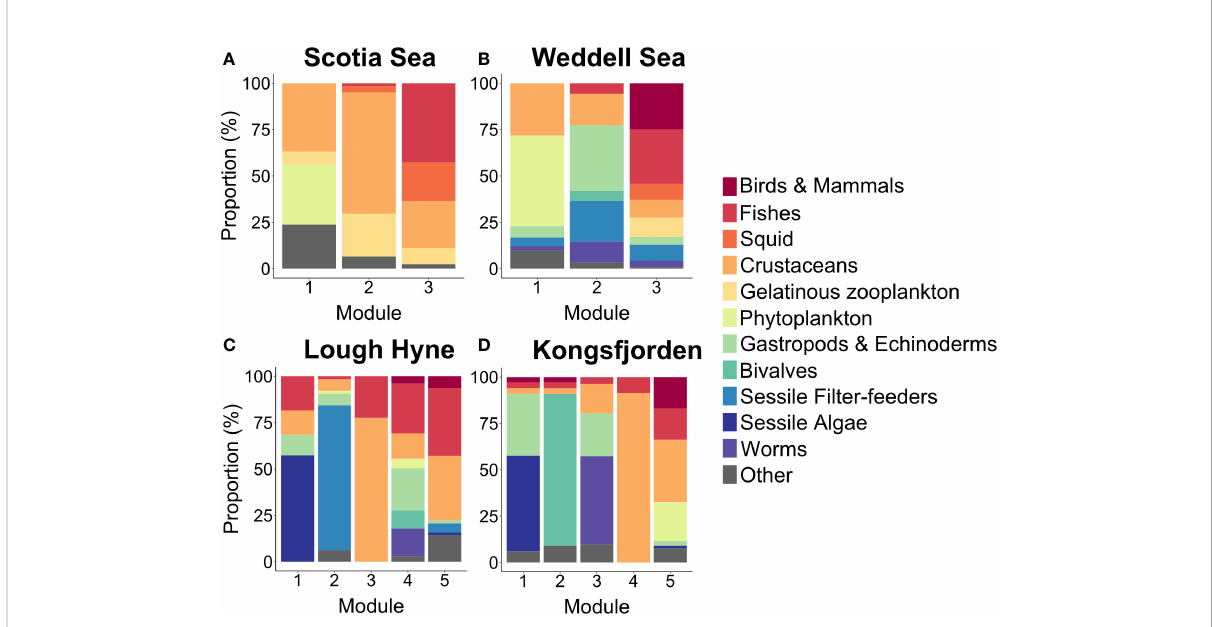
FIGURE 3 The relative proportion of different taxonomic groups within each module in the four food webs: (A) Scotia Sea; (B) Weddell Sea; (C) Lough Hyne; (D) Kongsfjorden. Species were initially grouped by taxonomy and then groups with few individuals were either combined (if they had similar ecology) or were assigned to the group “ Other ” . See Supplementary Data for an overview of species in each